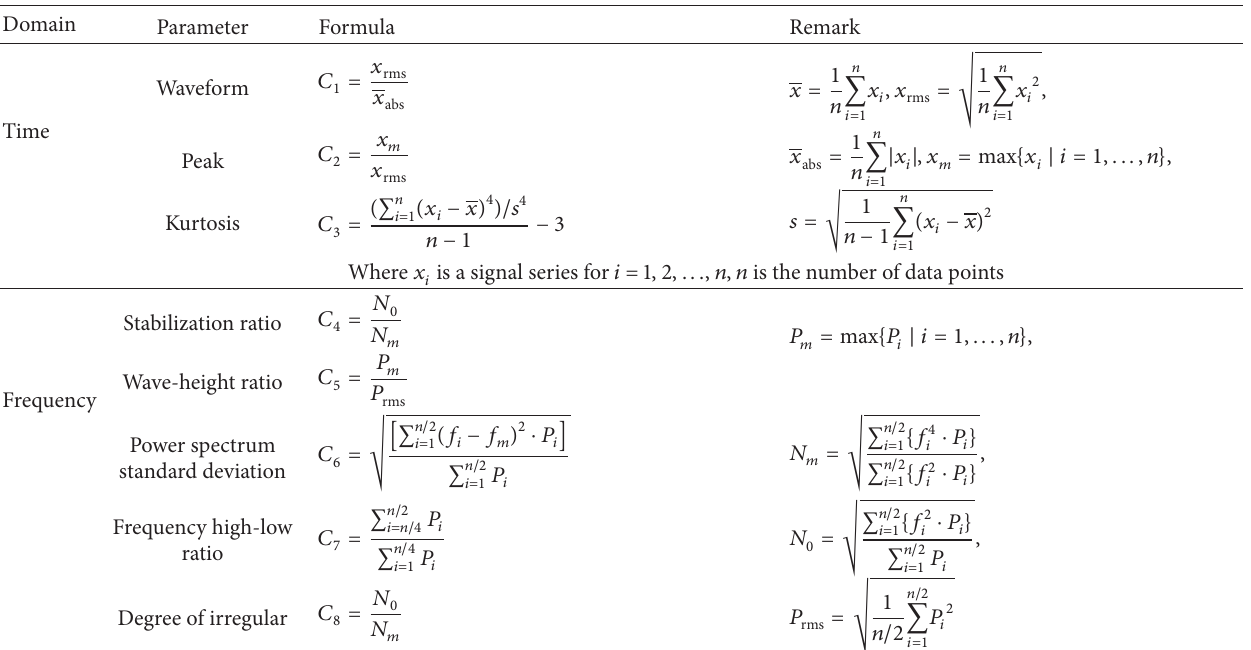
Table 1: Dimensionless statistical feature